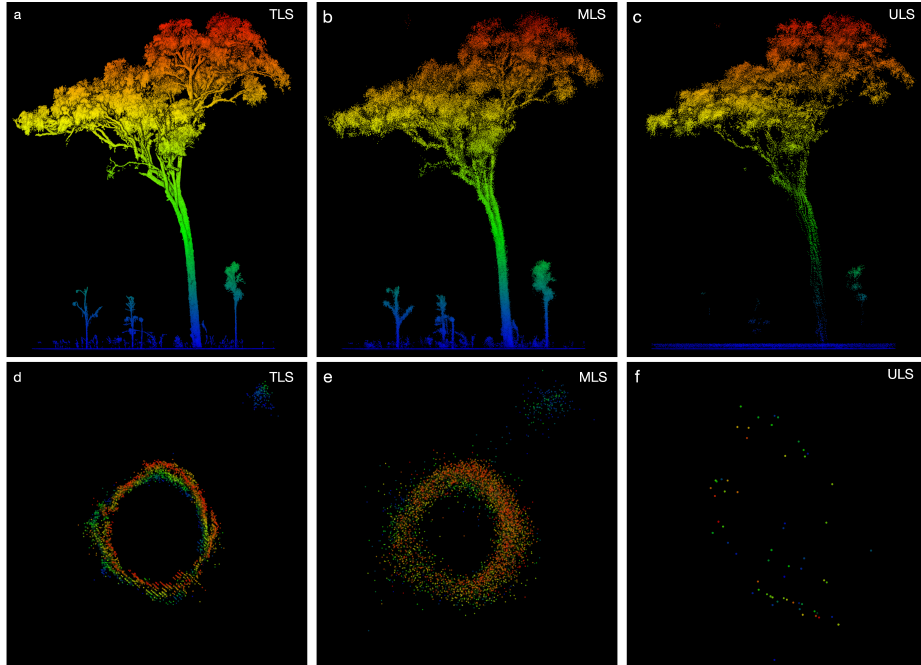
Figure 8. Example of a single large tree as captured by the three LiDAR systems ( a – c ). Horizontal slice cut through each stem at 1.25–1.35 m above ground level, showing the pattern and density of points available for DBH fitting from each system ( d – f